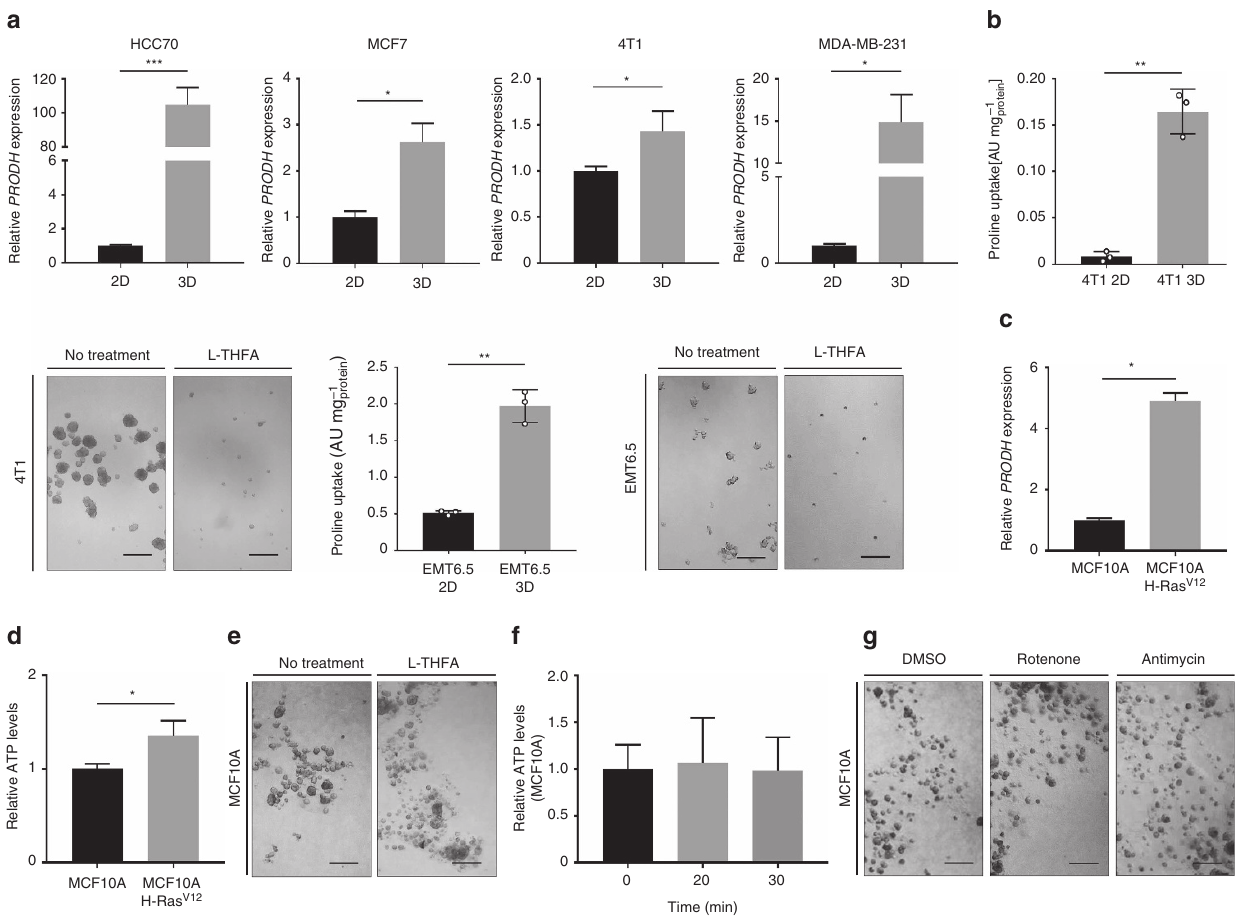
Figure 5 | Prodh activity is specifically relevant in transformed cells. ( a ) Relative expression of PRODH in HCC70, MCF7, 4T1 and MDA-MB-231 spheroids (3D) versus the corresponding attached (2D) cells. ( b ) Proline uptake of 4T1 and EMT6.5 spheroids versus attached cells and representative pictures of 4T1 and EMT6.5 spheroids with or without L-THFA treatment. Treatment was started at day 0. Analysis was performed 5 days after treatment. Scale bar: 150 m m (4T1 spheroids) and 75 m m (EMT6.5 spheroids). ( c ) Relative expression of PRODH in MCF10A H-Ras V12 spheroids compared to MCF10A acini. ( d ) Relative ATP levels of MCF10A H-Ras V12 spheroids compared to MCF10A acini. ( e ) Representative pictures of MCF10A acini with or